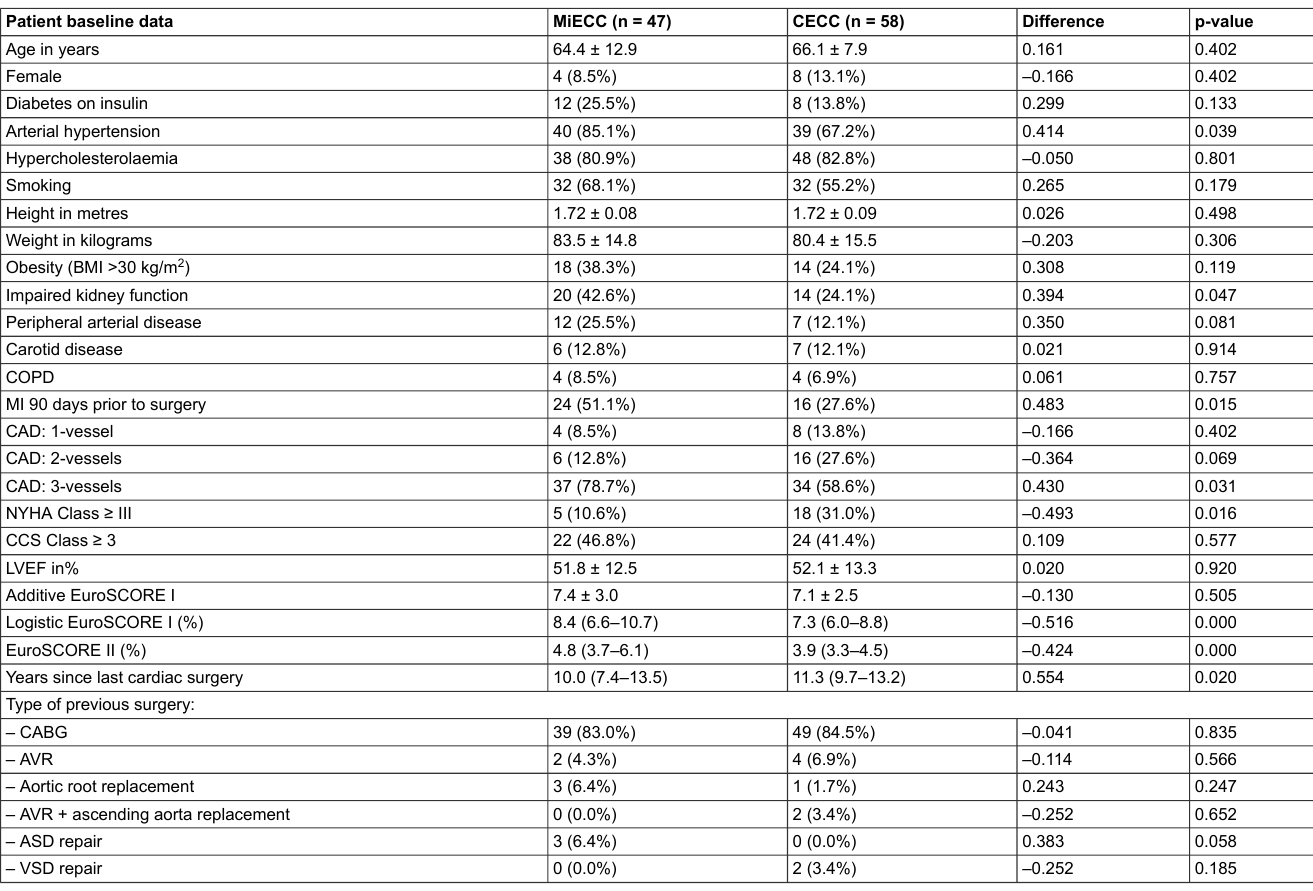
Table S1: Preoperative patient baseline data before propensity score matching and before inverse probability of treatment weighting (IPTW).